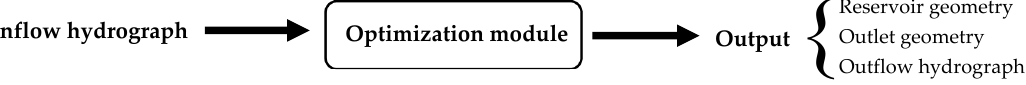
Figure 6. Conceptual framework of optimization approach for storage-based BMP.